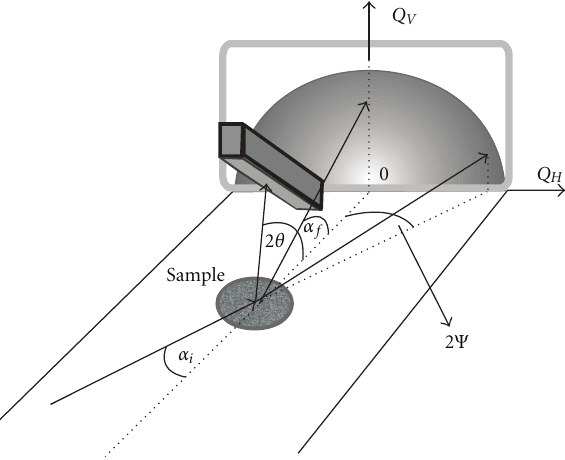
Figure 1: The geometry of GISAXS/GIXRD measurements: α i and α f are the incident and the exit angle of the X-ray beam, respectively; ψ is the scattering in-plane angle; Q H and Q V are the horizontal and the vertical scattering vector, respectively; 2 θ is the di ff raction